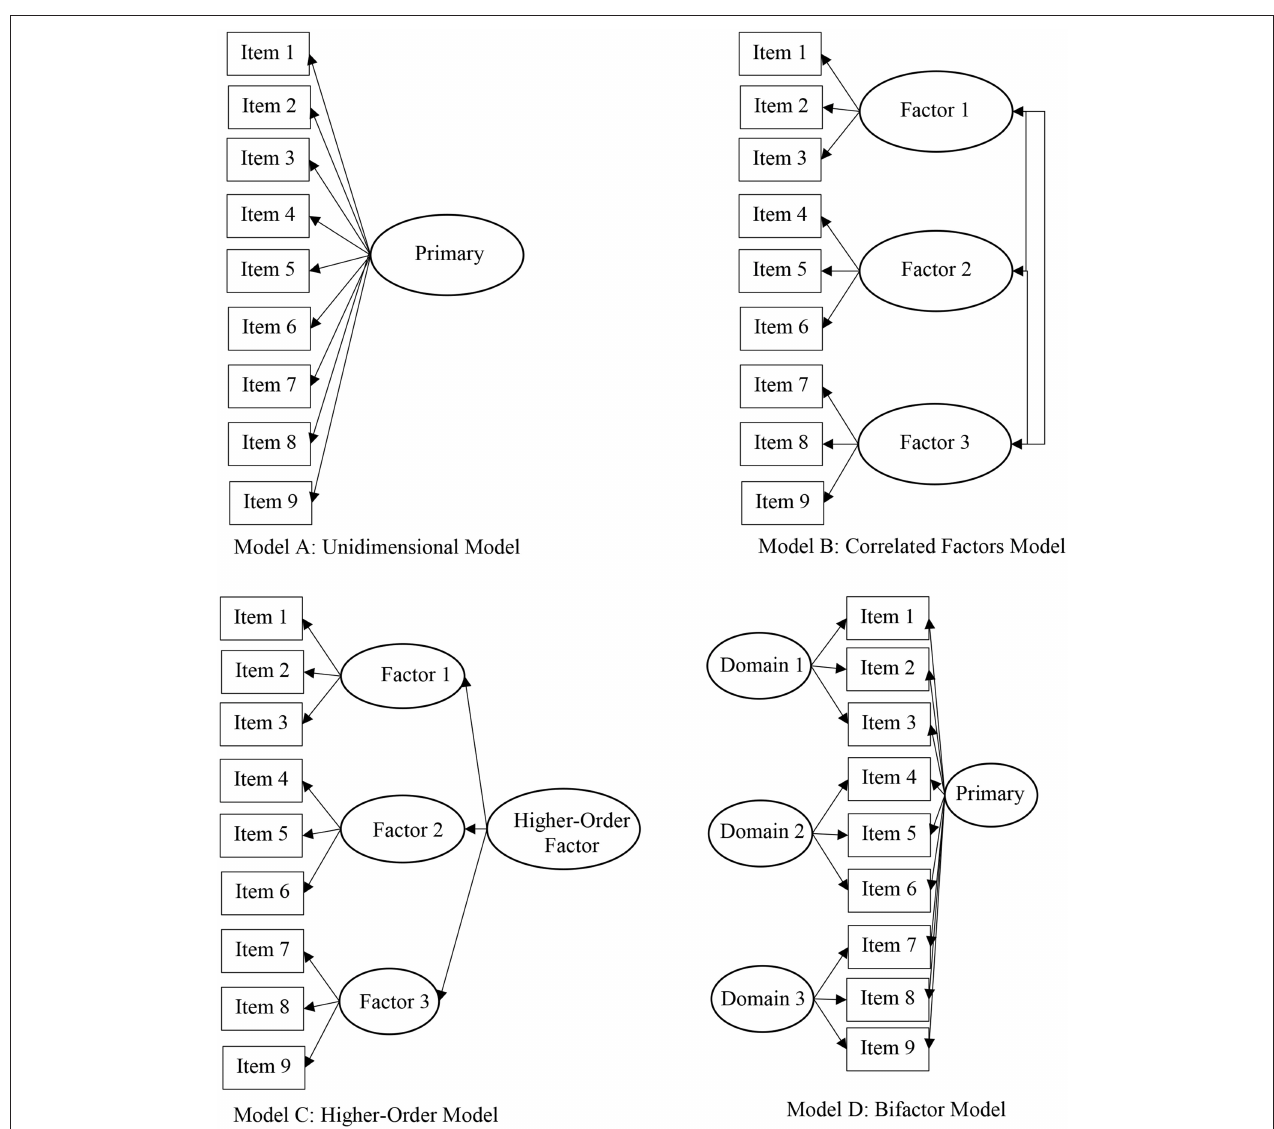
FIGURE 3 | Alternative factor structures of 9-item